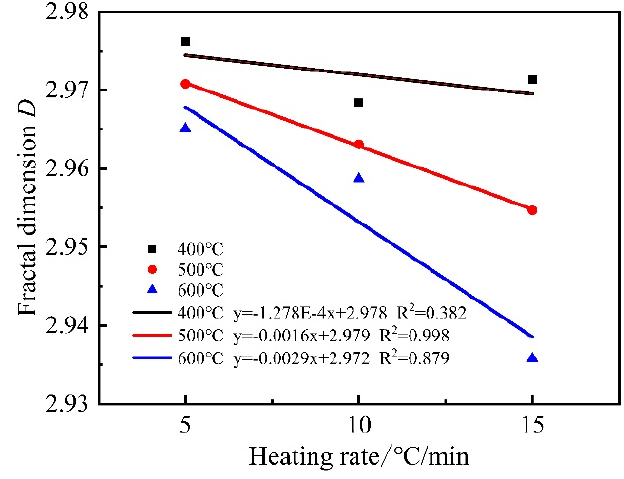
Figure 16. Relationship between fractal dimension and heating rate.